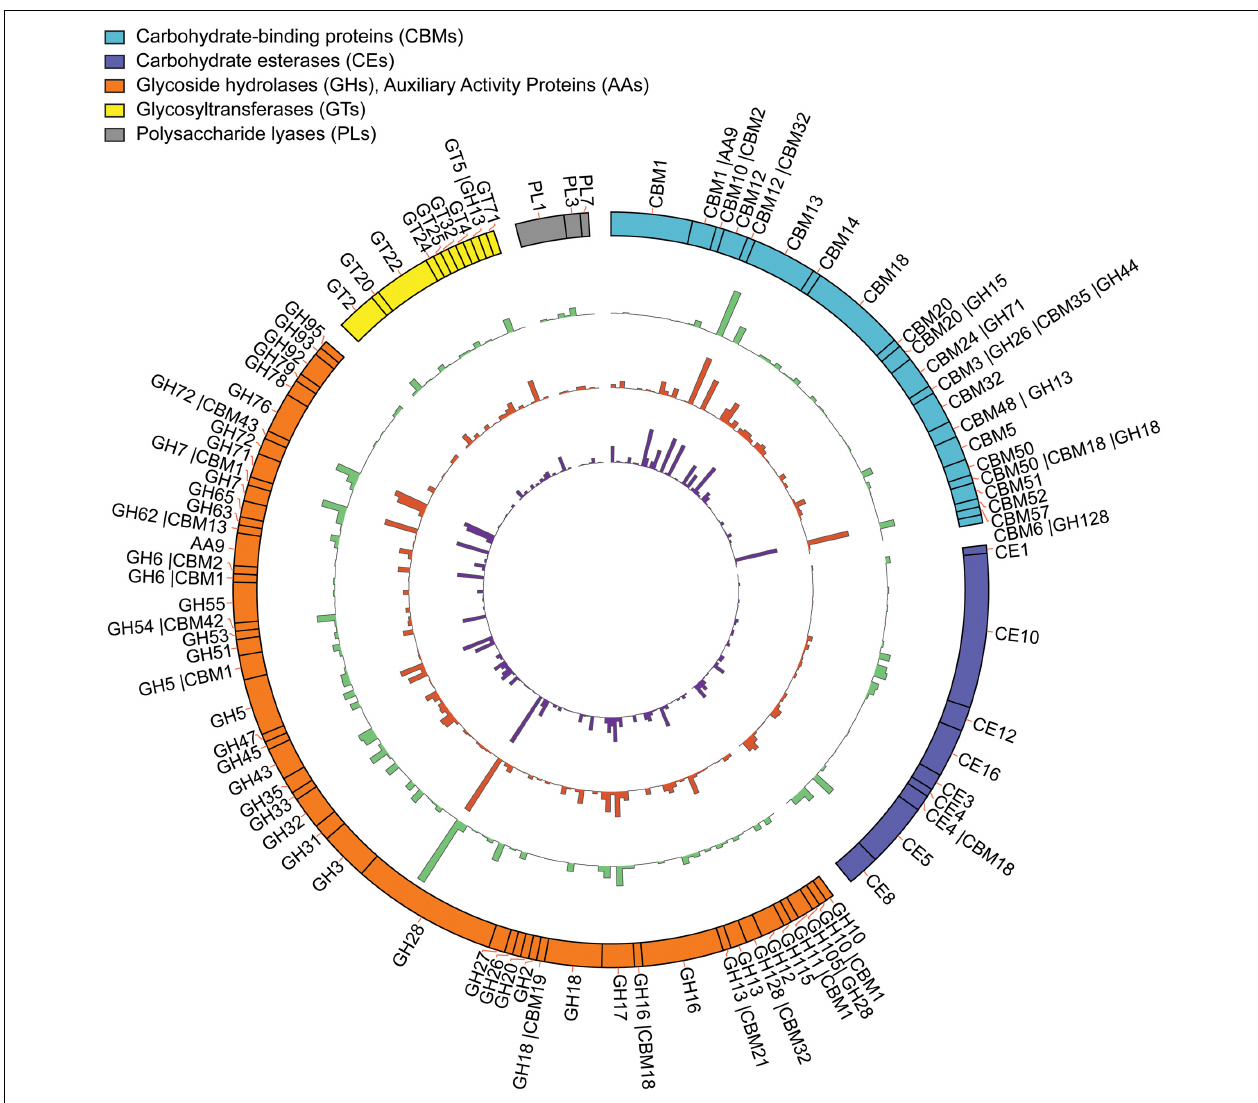
FIGURE 3 | Botrytis genes encoding predicted secreted CAZymes and their relative expression levels during infections of three plant hosts. The outermost ring represents all of the secreted CAZymes predicted in the Botrytis cinerea genome (strain B05.10). The inner four rings represent the relative expression of each CAZyme gene during Botrytis infections of lettuce